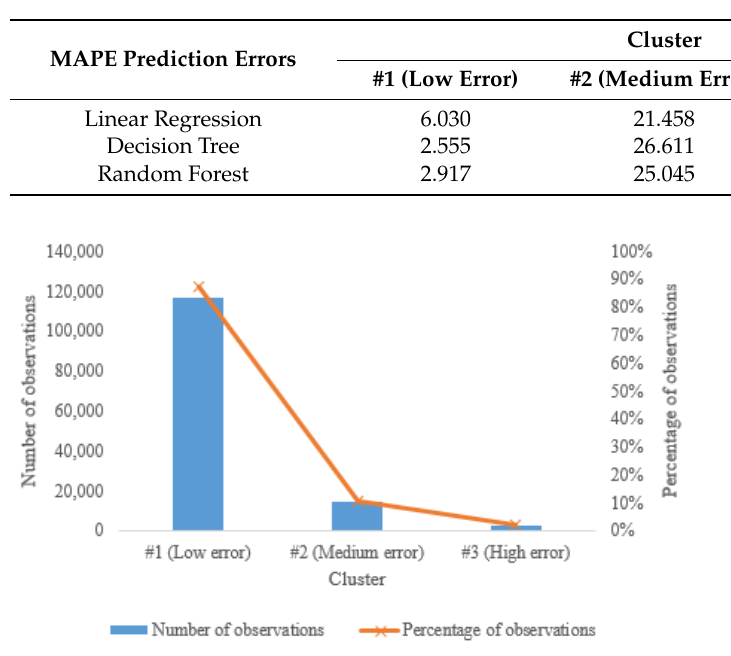
Figure 7. Number and percentage of observations per